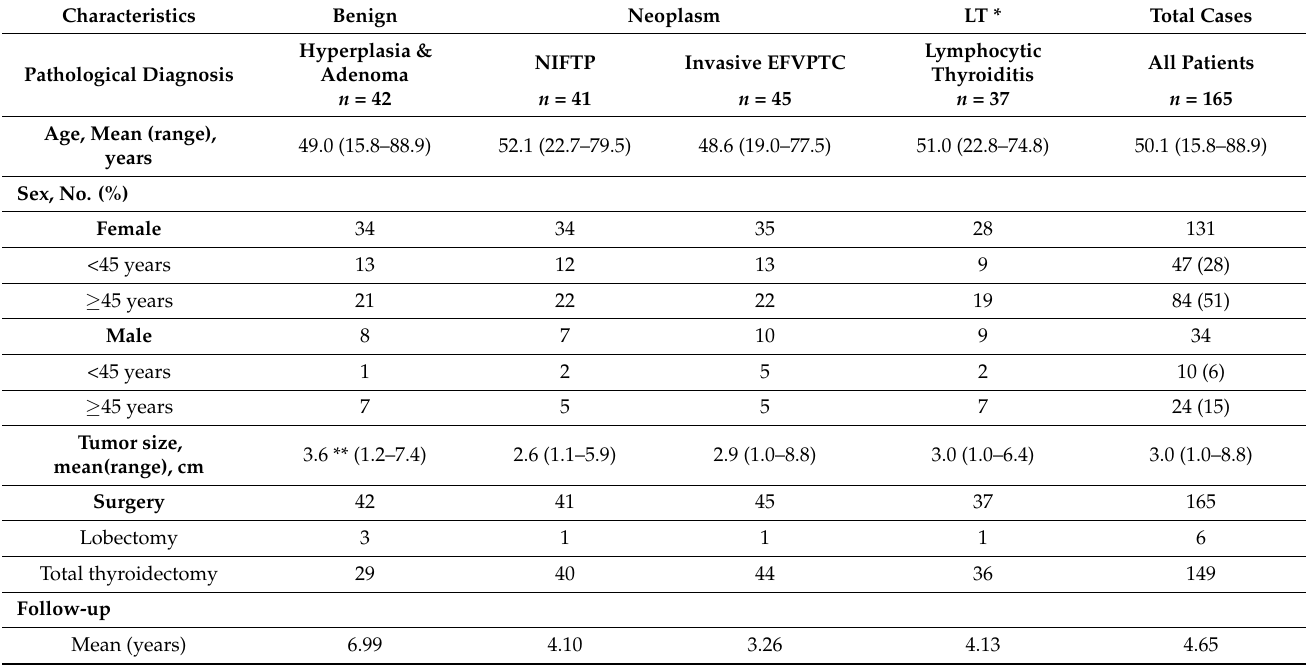
Table 1. Demographics and clinicopathologic features of the patient